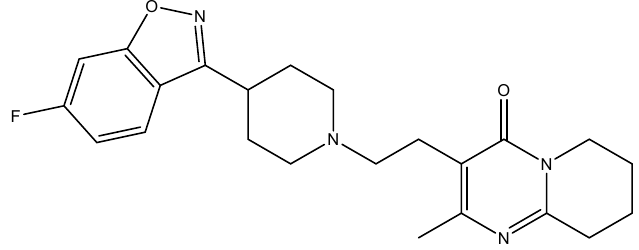
Figure 1. Structural formula of risperidone (RSP).